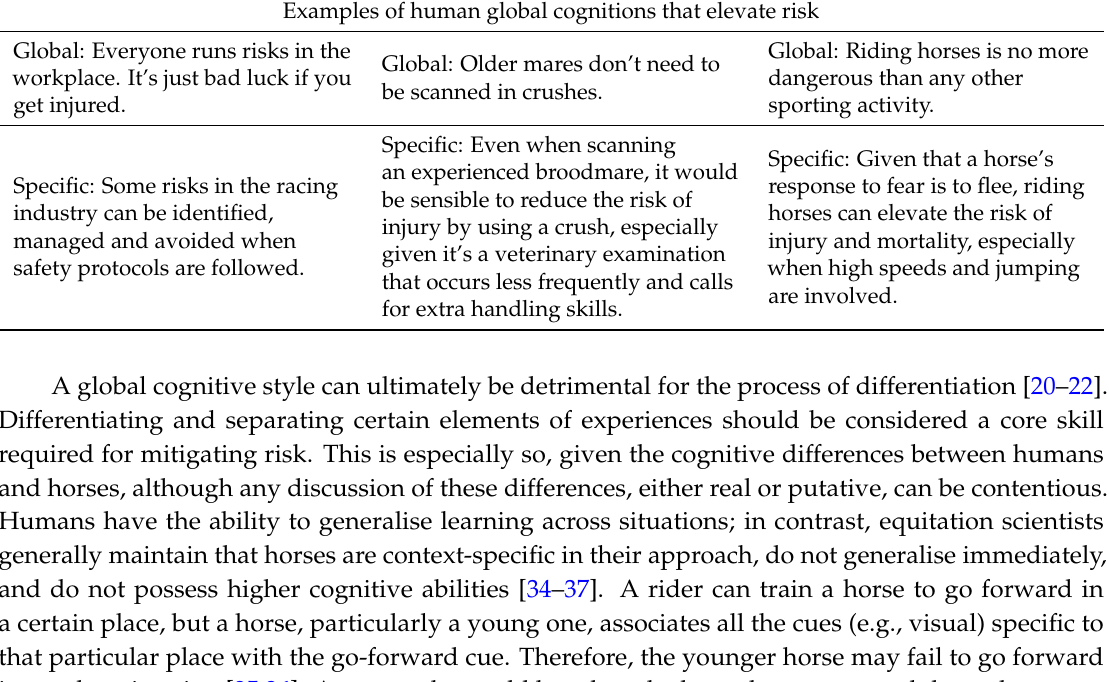
Table 3. Examples from track-work riders and jockeys, equine veterinarians and equestrian competitors that illustrate global cognitions that increase the risk of injuries. Track-Work Riders and Jockeys Equine Veterinarians Equestrian